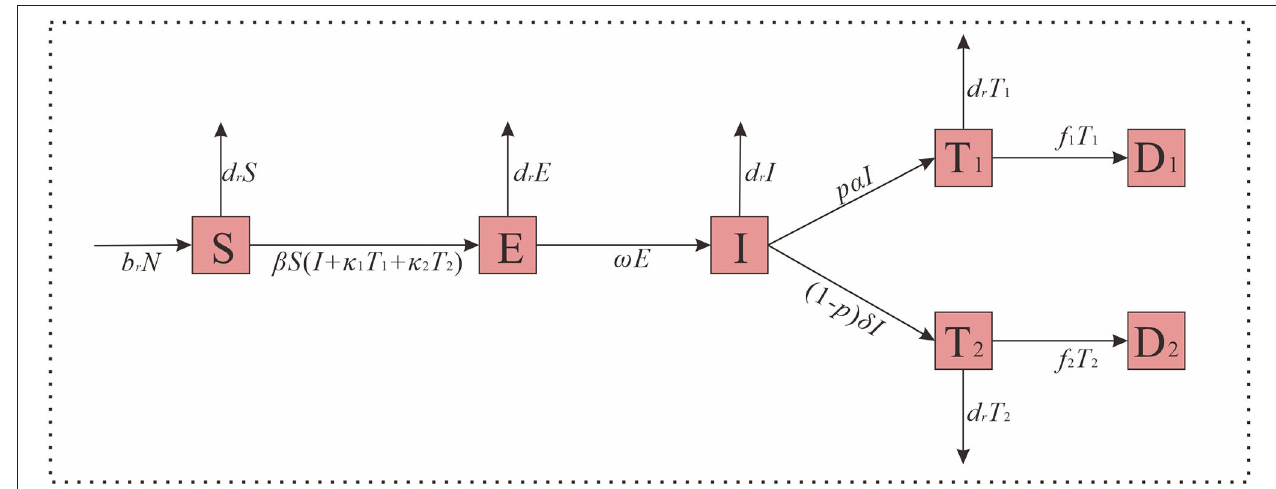
FIGURE 1 | The structure of HIV transmission dynamics model.